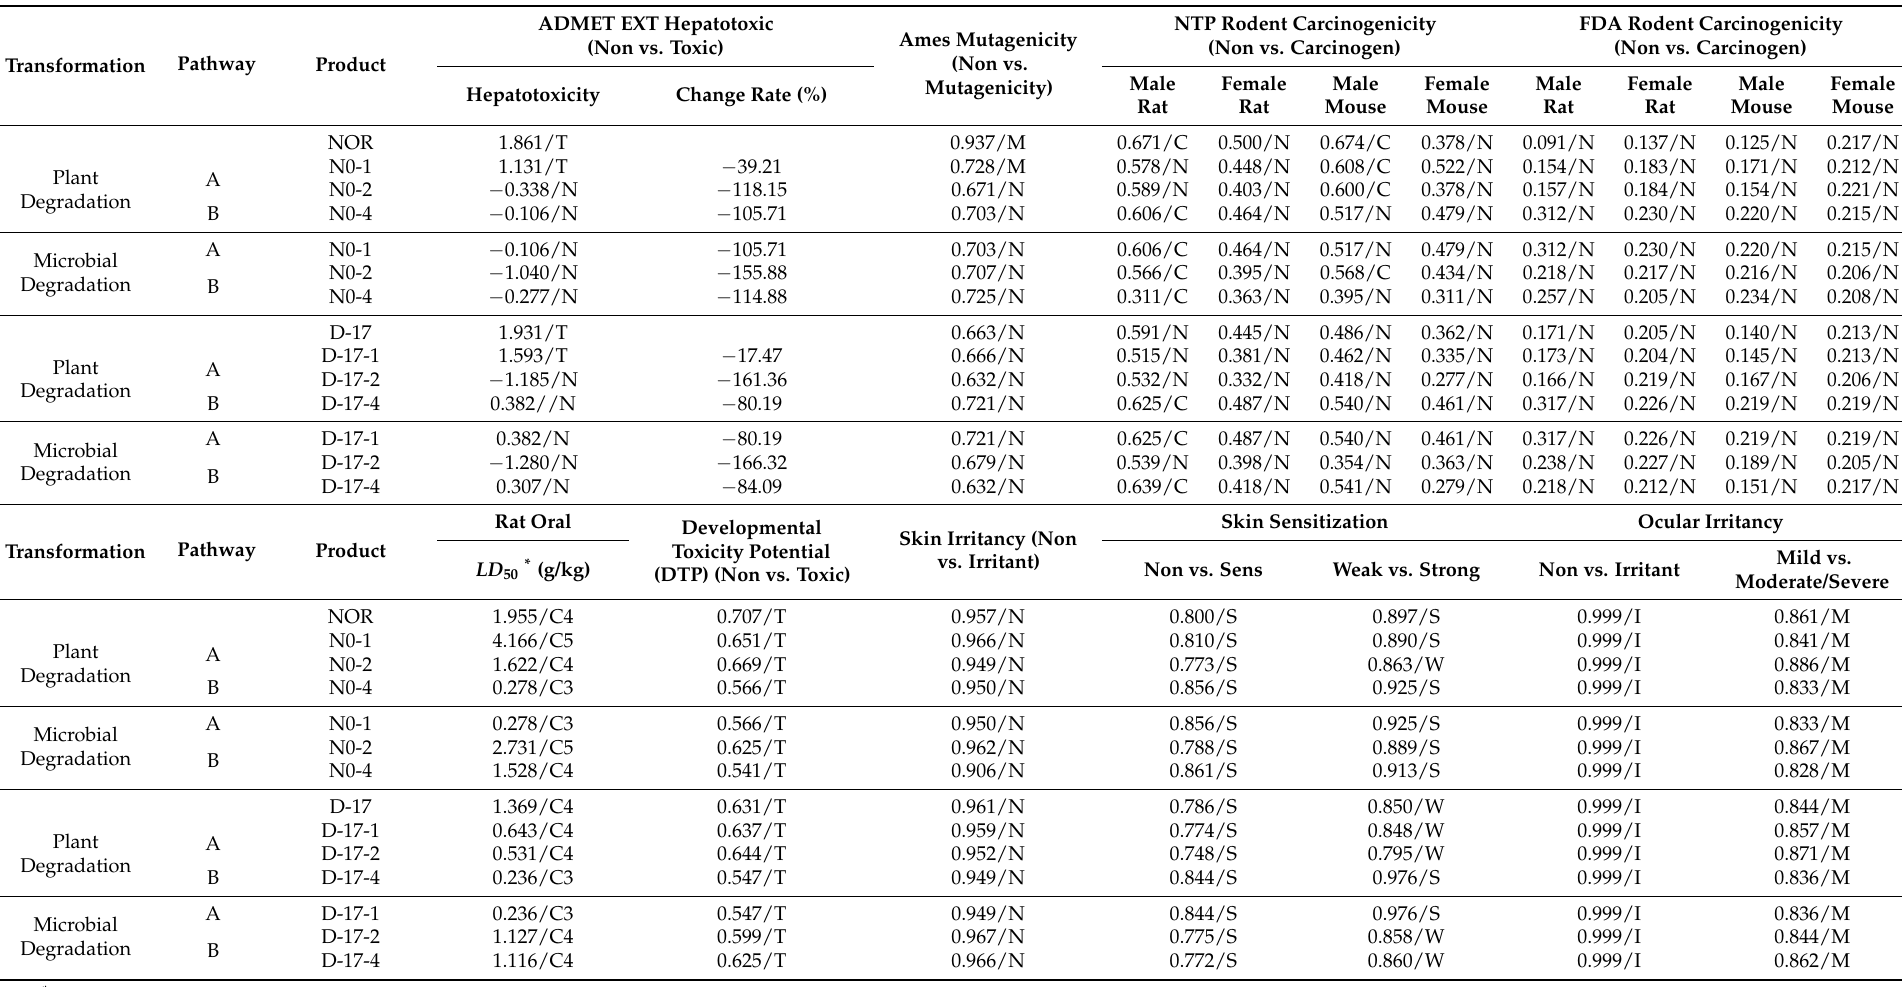
Table 9. Assessment of the human health risk raised by the plant and microbial transformation products of NOR prior to and after the modification based on pharmacokinetics and